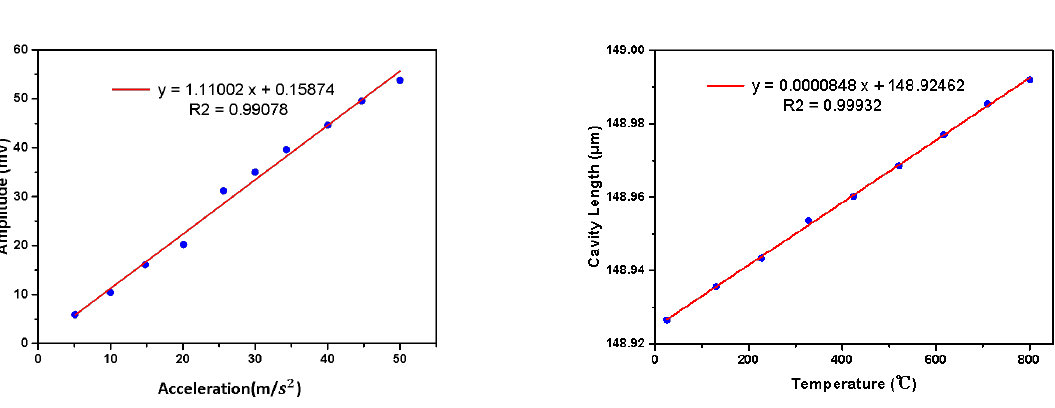
Figure 7: The acceleration response of the vibration sensor. Figure 8: The relationship between the cavity length and the ap- plied